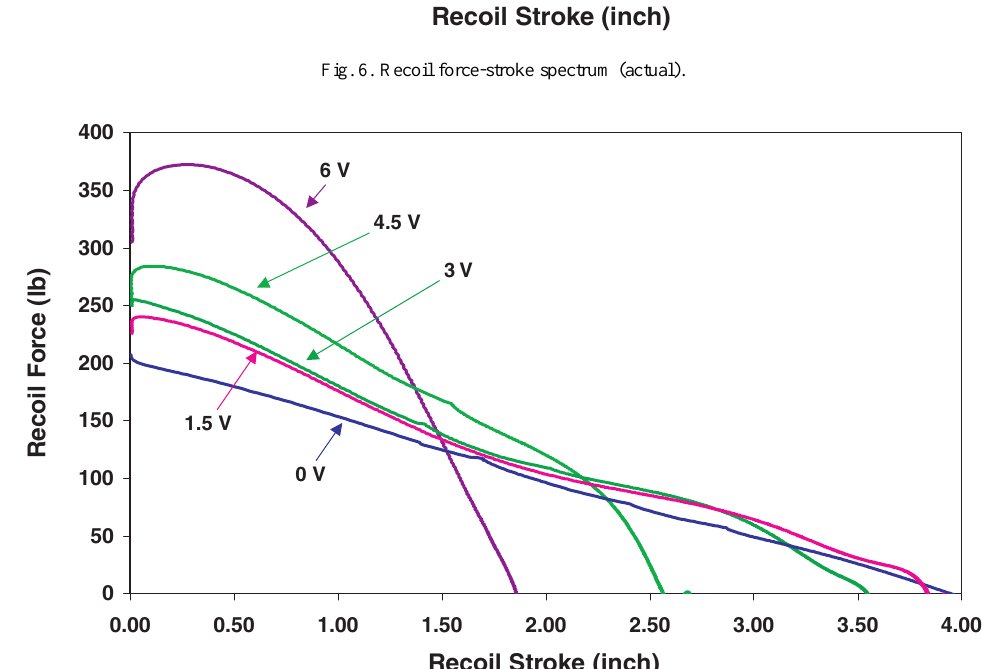
Fig. 7. Recoil force-stroke spectrum